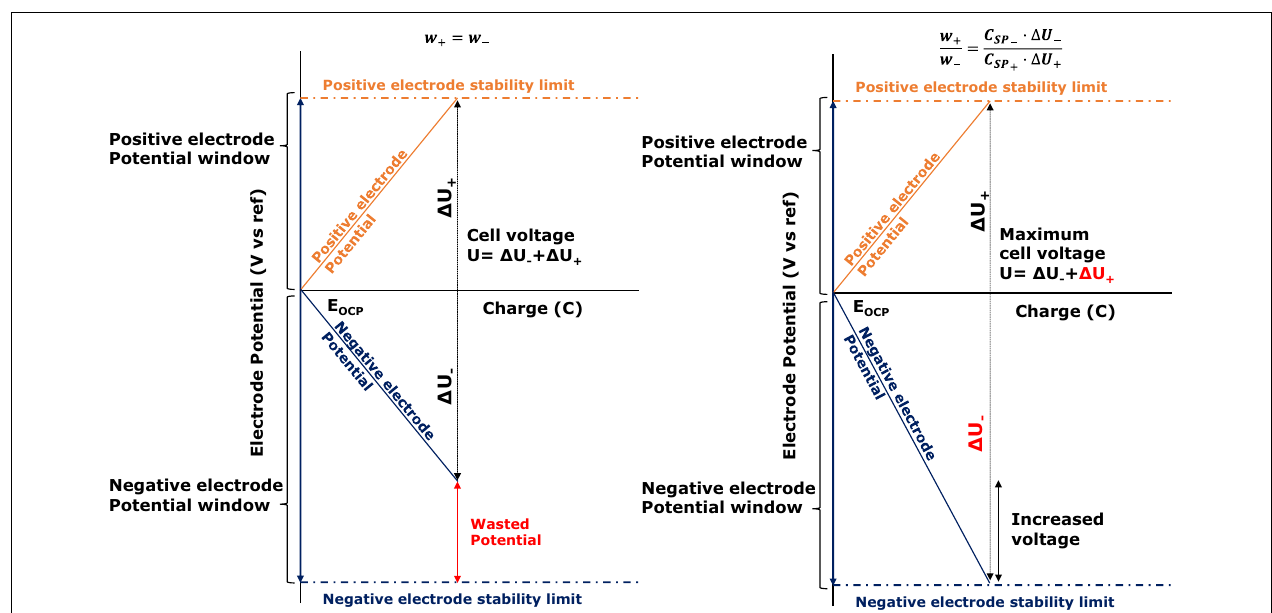
FIGURE 1 | Scheme of the relationship between electrode potentials, voltage, and charge in symmetric (left) and asymmetric (right) supercapacitors .